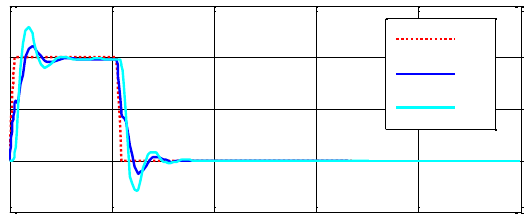
Figure 7: Transient plots of signals v P 1 and v P 2 .